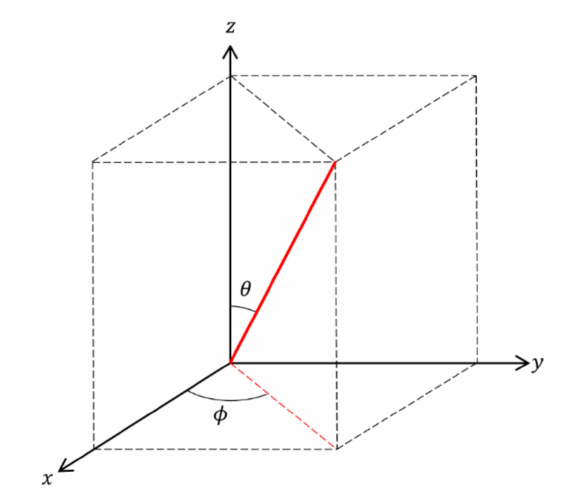
Figure 7. Defined orientation angles of